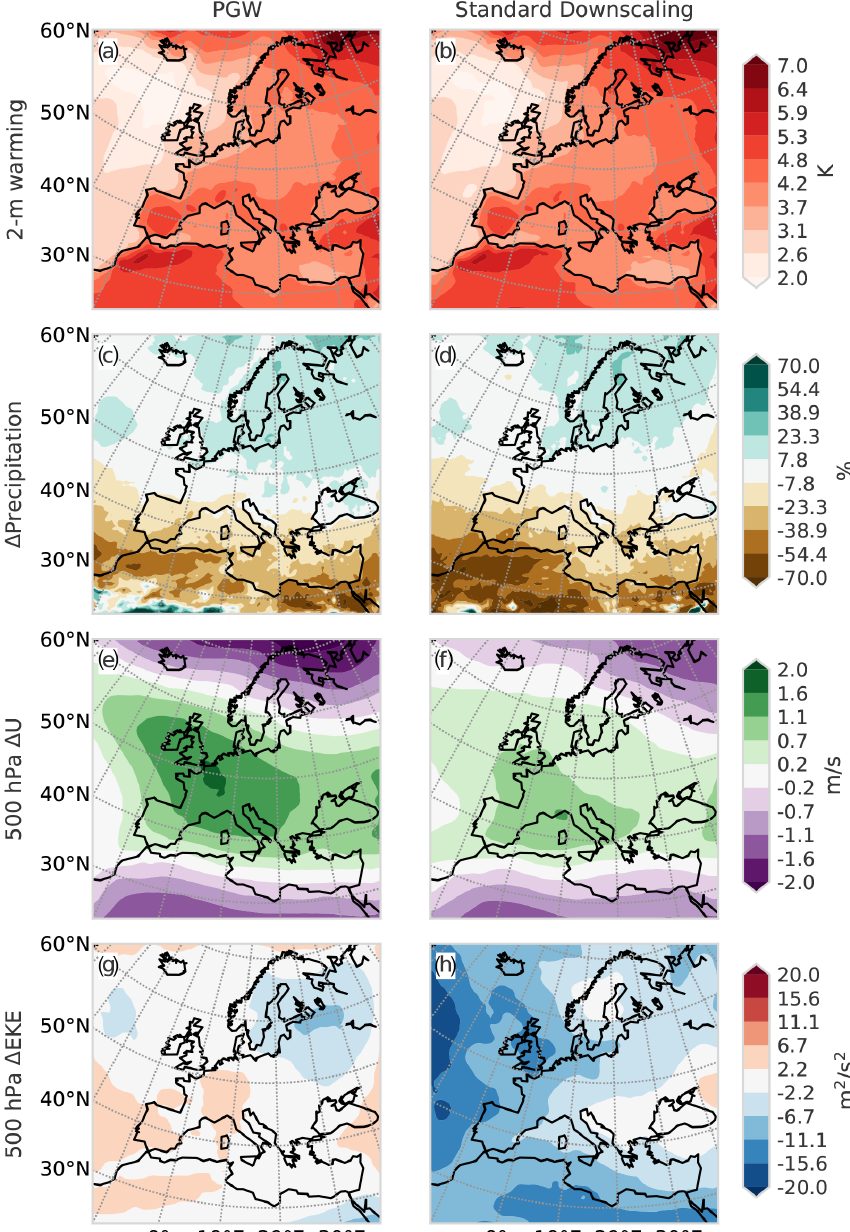
Figure 7. Comparison of annual mean climate change projections derived from (left) PGW and (right) standard downscaling methodolo- gies for the time periods 2070–2099 versus 1971–2000 using an RCP8.5 emission scenario. (a–b) 2m temperature change, (c–d) mean precipitation change, (e–f) mid-tropospheric zonal wind change, and (g–h) mid-tropospheric change in eddy kinetic energy (calculated as 0 . 5 ((u − u) 2 + (v − v) 2 ) , with (u,v) the instantaneous value of the wind and (u,v) the 30-year mean thereof). Details on the simulation setup can be found in Table